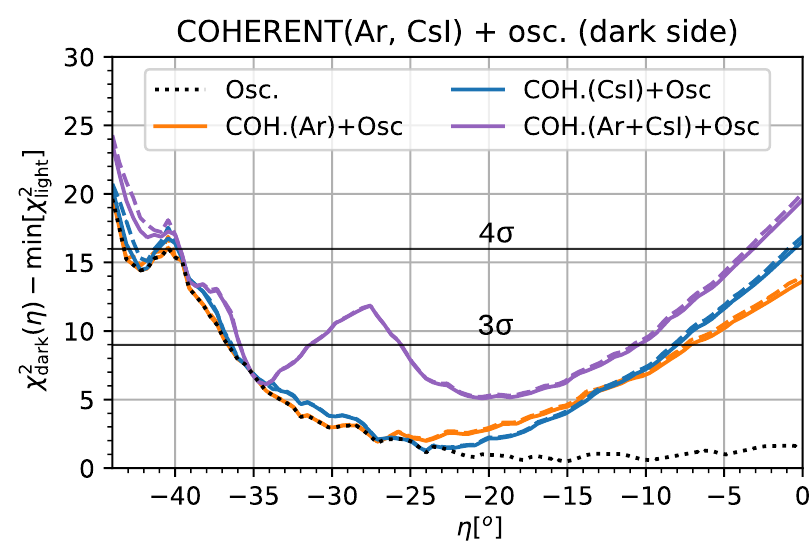
Figure 1 . ∆ χ 2 of the LMA-dark solution minimized with respect to (cid:15) η oscillation data (black), oscillations+Coherent (CsI) (blue), oscillations+Coherent (Ar) (orange), and all three data sets combined (purple). For dashed curves the off-diagonal (cid:15) η for solid curves we minimize with respect to